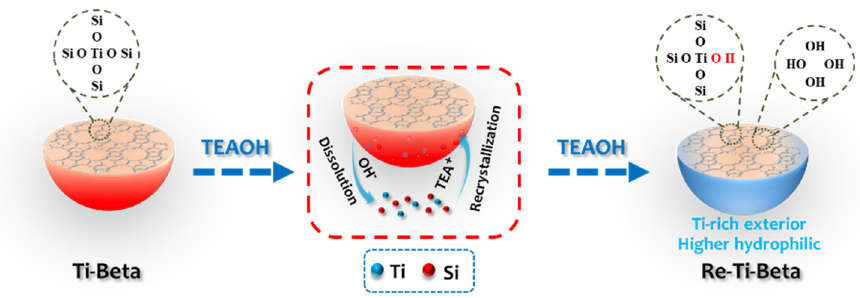
Scheme 1. Schematic description of the modification of Ti − Beta by TEAOH